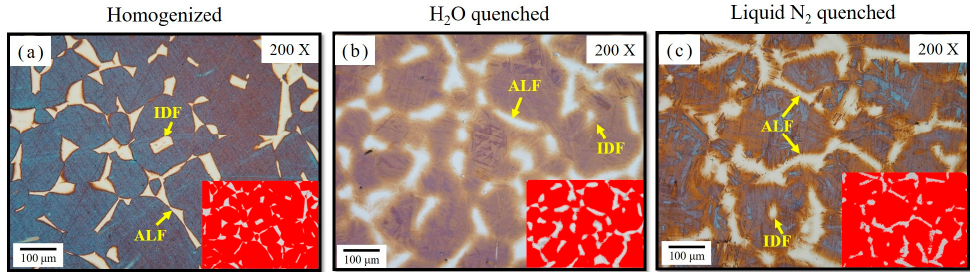
Figure 2. Microstructures of type 17-4 PH color metallography etched with Beraha’s sulfamic acid reagent for ( a ) water quenched homogenization; ( b ) water quenched solid solution; ( c ) liquid nitrogen quenched solid solution. (Image J pictures for phase volume measurement inserted at the bottom right).